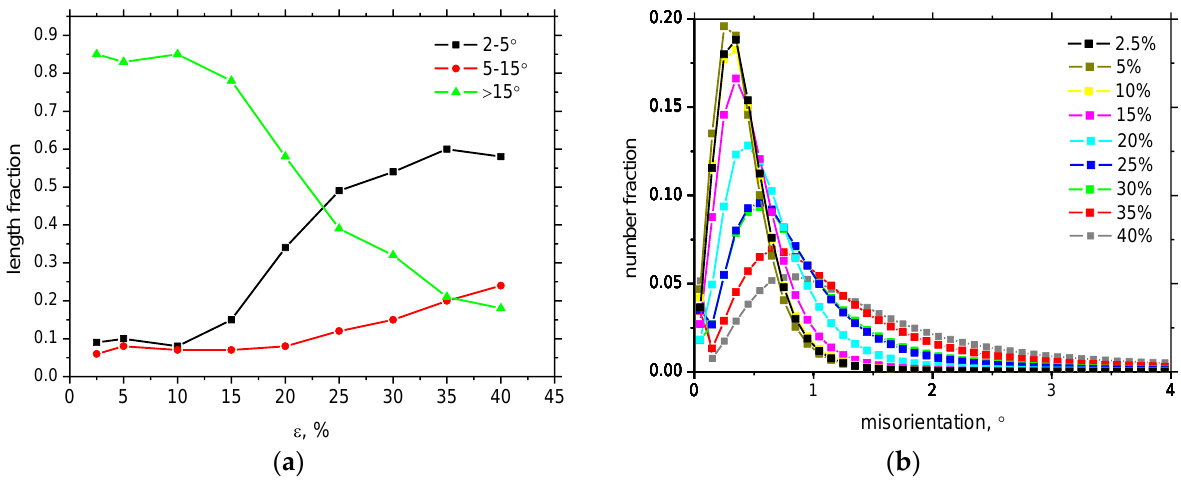
Figure 7. ( a ) Length fraction evolution of different boundary types as a function of ε and ( b ) normalised distribution of misorientation in the range of 0 – 5°.